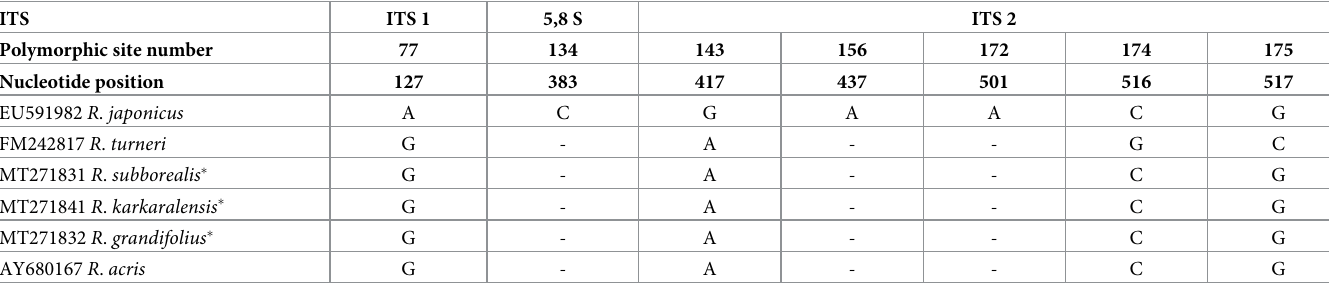
Table 1. Polymorphic nucleotide sites of R . japonicas , R . turneri , R . grandifolius , R . acris , R . subborealis , and R . karkaralenis in ITS. ITS ITS 1 5,8